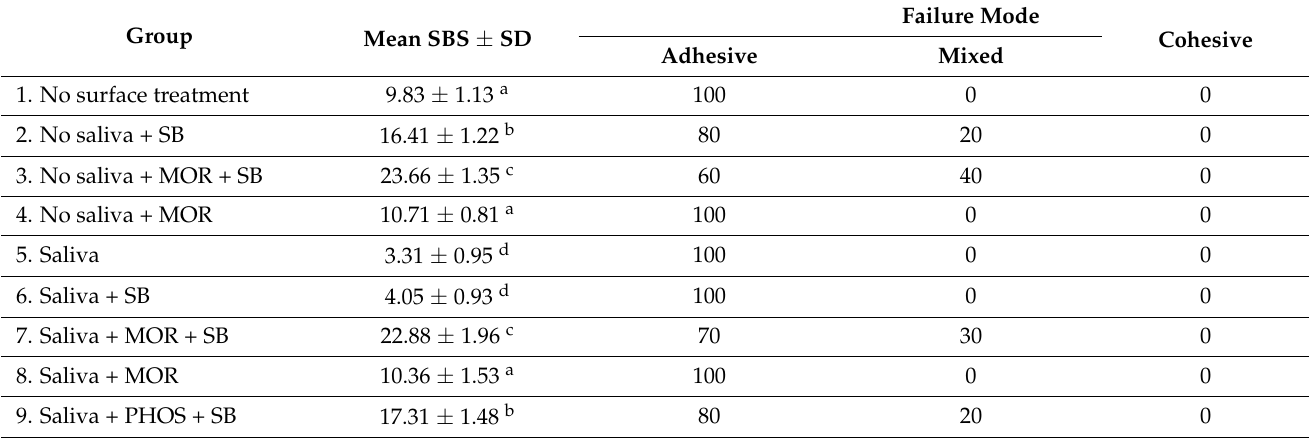
Table 2. The SBSs’ means and standard deviation (MPa) and failure mode percentage. Failure Mode Group Mean SBS ± SD Cohesive Adhesive